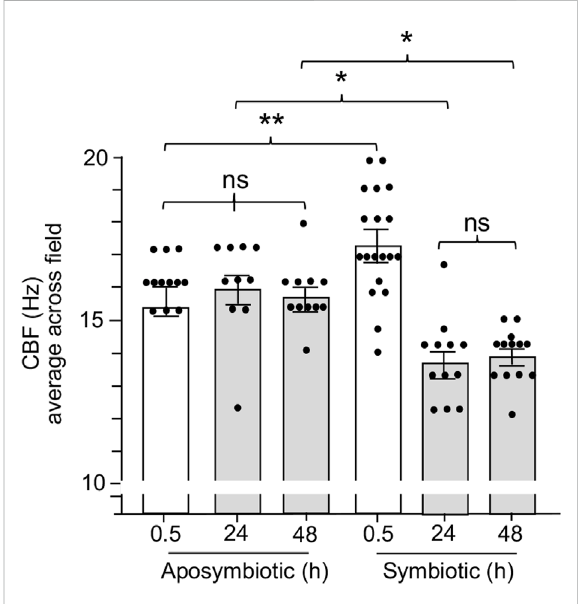
FIGURE 6 The effect of light organ colonization on CBF. Animals were inoculated with 5,000 CFU Vibrio fi scheri per ml of NSW for symbiotic treatment, or only natural seawater (NSW) for aposymbiotic treatment. For treatments longer than 0.5 h, animals were rinsed twice in NSW after 3 h of exposure to